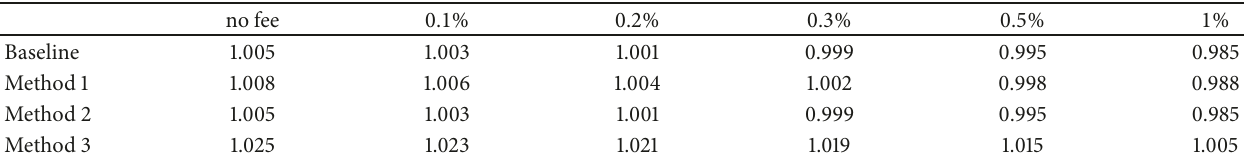
Table 1: Daily geometric mean return for different transaction fees. Results are obtained considering the period between Jan. 2016 and Apr. 2018.